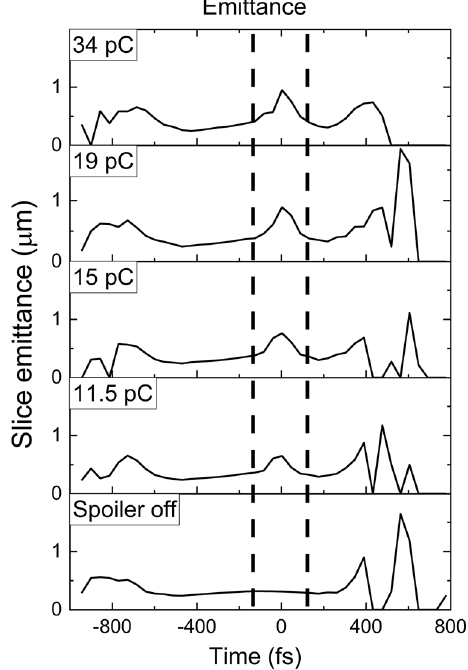
FIG. 2. Beam slice emittance measured at the injector for different laser spoiler pulse energies. In the legend of each graph, the charge generated by the laser spoiler is reported. The slice emittance stays constant along the bunch when the laser emit- tance spoiler is switched off (lower panel). As the laser emittance spoiler is activated and increased in intensity the emittance grows at the temporal overlap at time zero and is delimited by the two dashed lines at -150 fs and 150